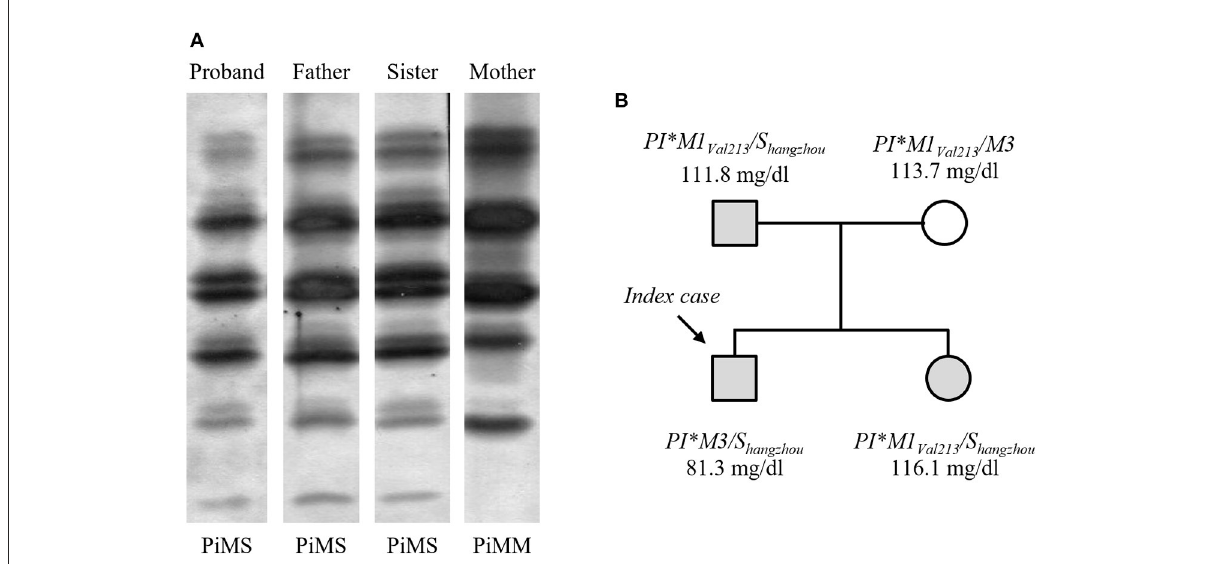
FIGURE1 Family study of AATD. (A) AAT phenotypes determined by IEF analysis. (B) Pedigree of the proband’s family showing the genotypes for SERPINA1 gene and serum AAT levels. Carriers of the S hangzhou allele are highlighted in gray.